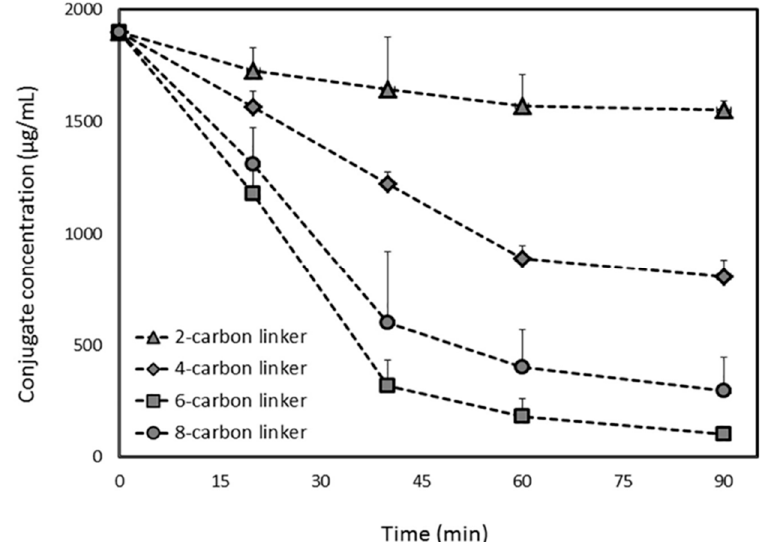
Figure 5. PLA 2 -mediated in-vitro activation of PL-diclofenac conjugates with linker lengths of 2, 4, 6 and 8-carbons. Reproduced with permission from reference [30], Elsevier, 2017.